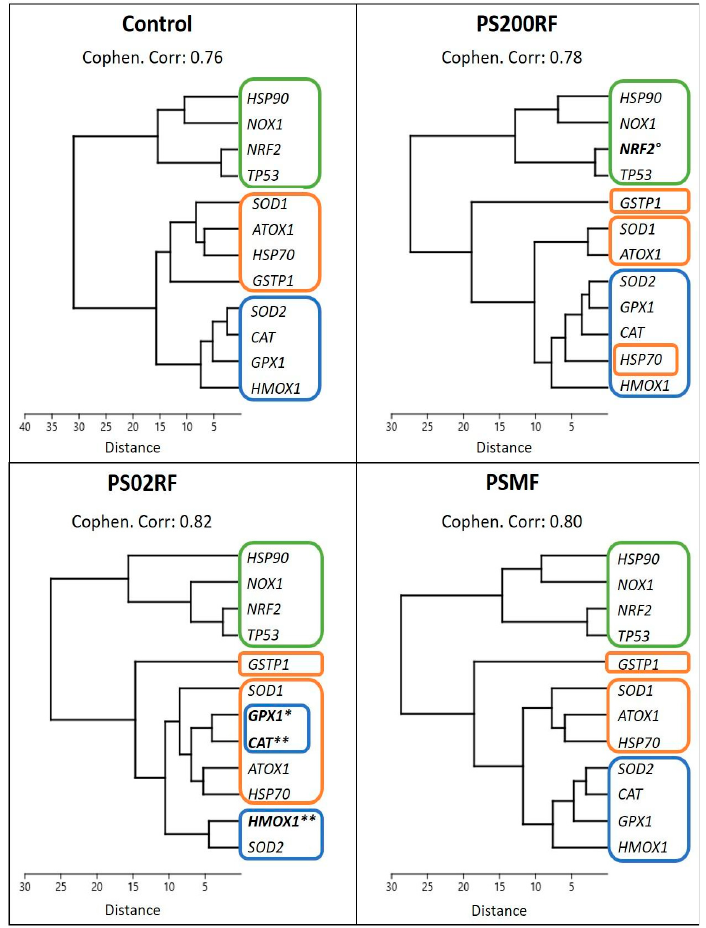
Figure 5. Hierarchical clustering of gene expression results per treatment group. Unweighted pair group method with arithmetic mean (UPGMA) with Euclidean distance was used to construct the dendrogram. Cophenetic correlation coefficient was calculated to measure the significance of the clustering process. Each coloured rectangle represents a cluster with the control condition as baseline. Gene names in bold were statistically significant compared to control ( n = 10–17 from 3 independent experiments) (based on Figure 4A).